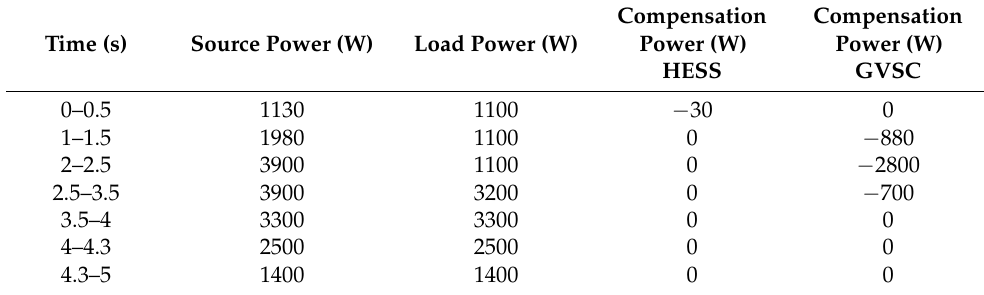
Table 5. Mode of operation 4.